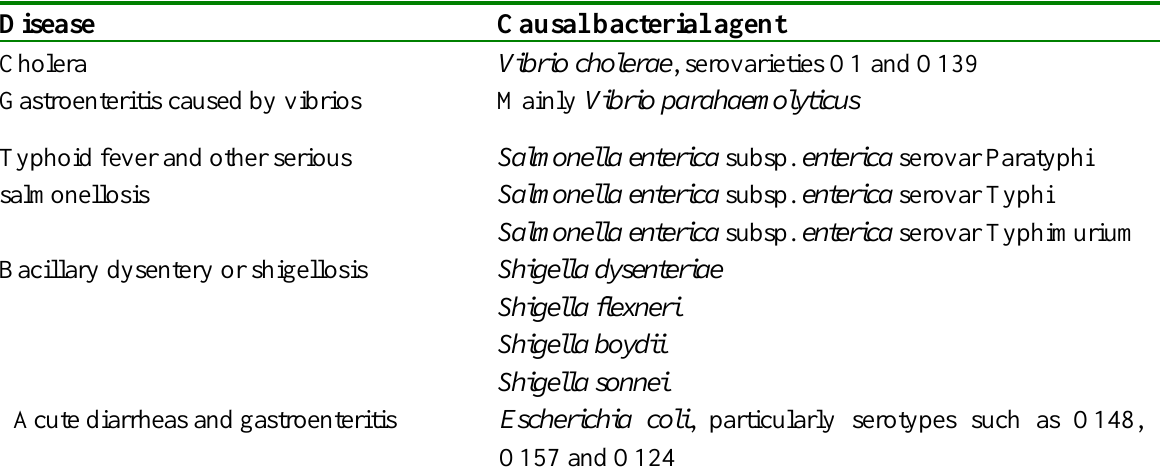
Table 1. The main bacterial diseases transmitted through drinking